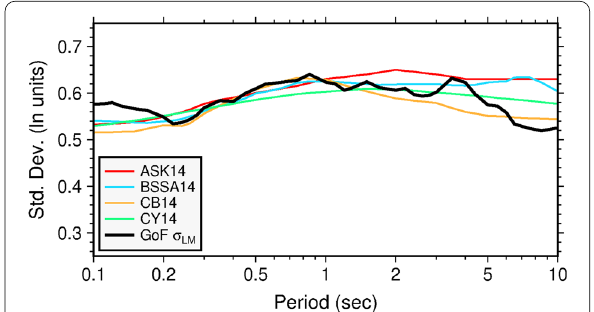
Fig. 11 Comparison of the standard deviation computed from the residuals for the lowest misfit simulations across all 12 validation events (GoF σ LM ) with the intra-event standard deviations from ground motion prediction equations (GMPEs). GMPEs are as follows: ASK14, Abrahamson et al. (2014); BSSA14, Boore et al. (2014); CB14, Campbell and Bozorgnia (2014); and CY14, Chiou and Youngs (2014). The intra-event terms from the GMPEs are determined for an event magnitude of 7.0, site distance of 40 km and V s30 of 400 m/s